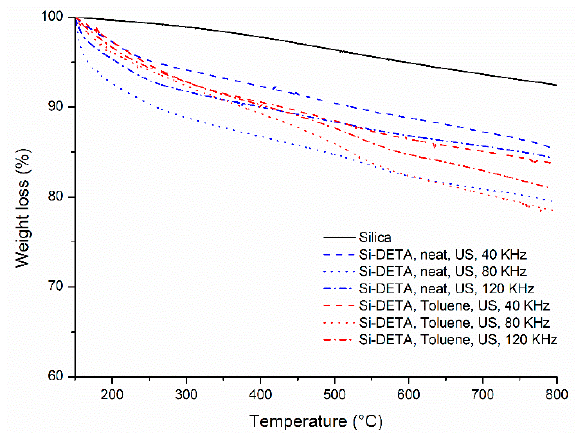
Figure 3. TGA profiles of silica and Si-DETA obtained using US irradiation at different frequencies (40–80–120 kHz), in neat conditions (Table 1, Entries 7–9, blue lines) and in toluene (Table 1, Entries 4–6, red lines). Solid line, starting silica; blue, dashed line, Si-DETA, neat, US 40 kHz, Table 1, Entry 7; blue, dashed-dotted line, Si-DETA, neat conditions, 120 kHz, Table 1, Entry 9; red, dashed line, Si-DETA, toluene, 40 kHz, Table 1, Entry 4; red, dashed-dotted line, Si-DETA, toluene, 120 kHz, Table 1, Entry 6; blue, dotted line, Si-DETA, neat conditions, 80 kHz, Table 1, Entry 8; red, dotted line, Si-DETA, toluene, 80 kHz, Table 1, Entry 5.